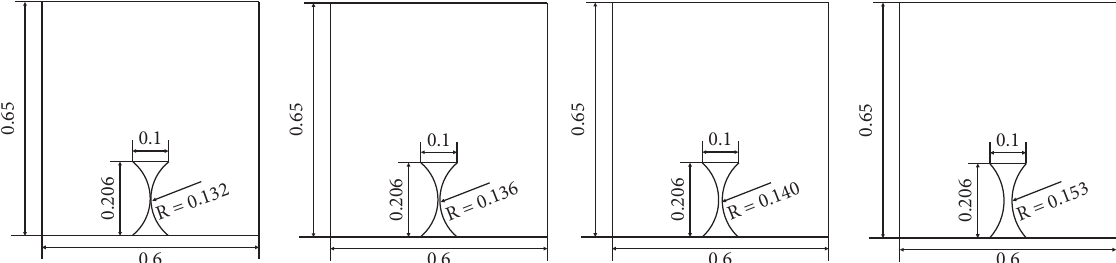
Figure 19: Double-side curved baffle with different radians (unit: m).